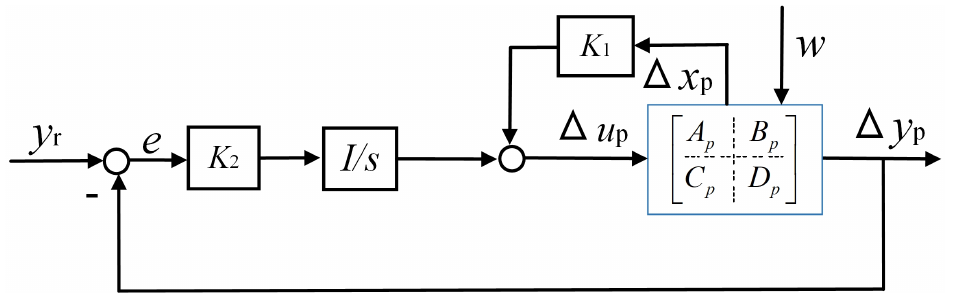
Figure 1. Diagram of output tracking control with a step